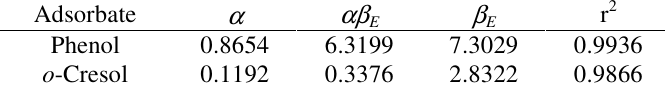
Table 5. Elovic parameters for the adsorption of phenols on CC